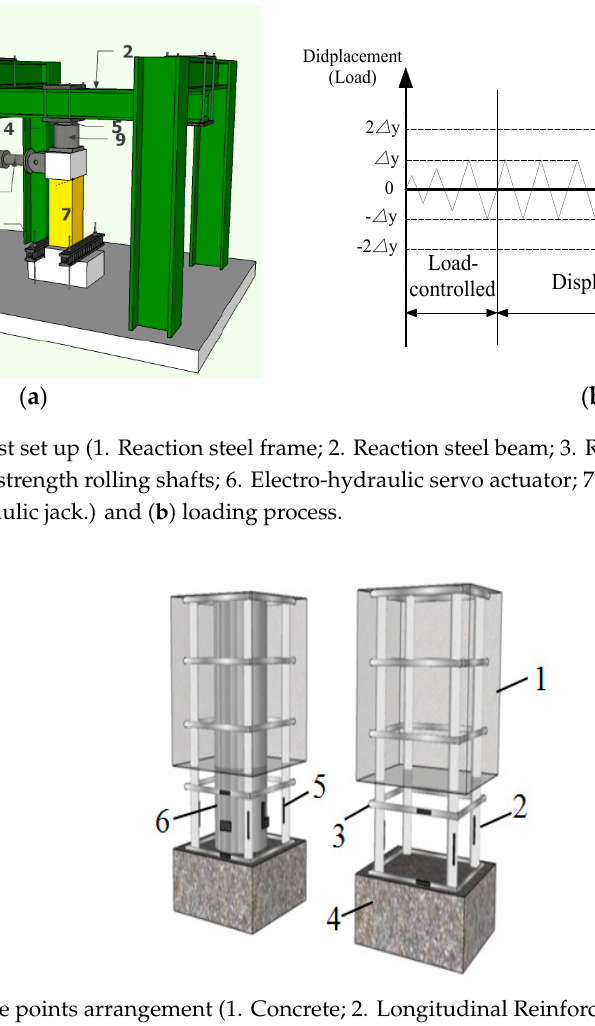
Fixed end; 5. Gauge points; 6. PVC (CST).) .